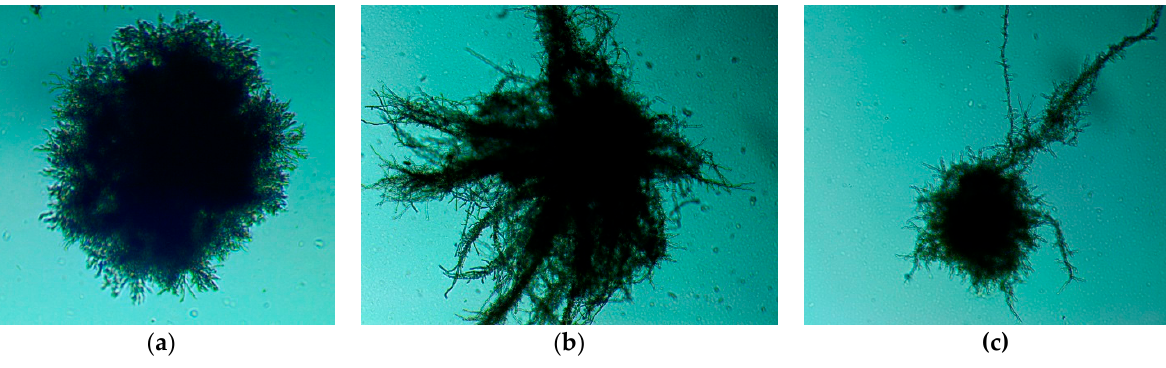
Figure 3. Pellets’ shapes in presence of n -dodecane ( a ) and absence of n -dodecane ( b , c ) on the third day of fermentation .